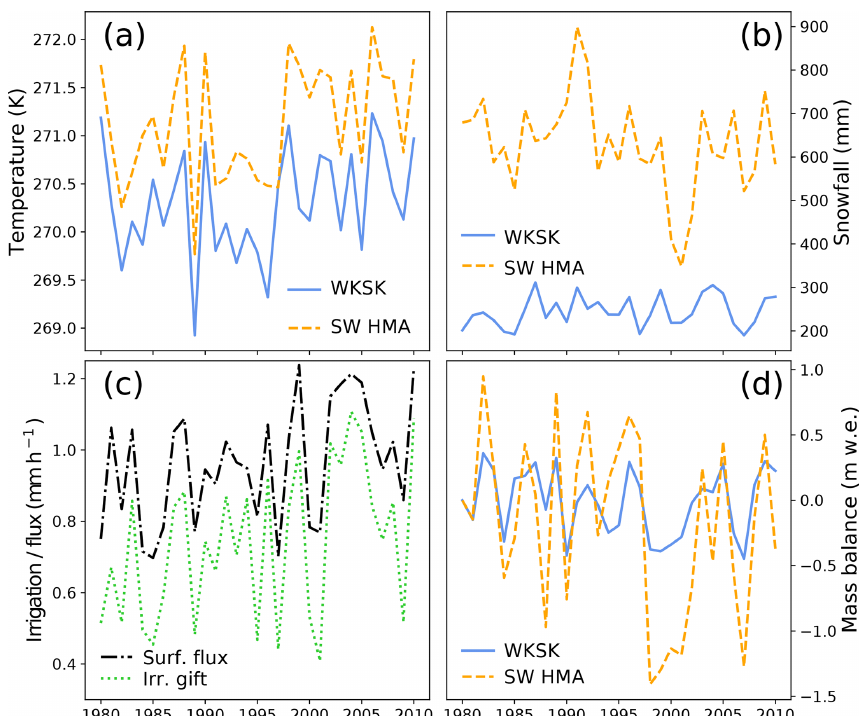
Figure 9. Time series of annual mean temperature (a) , annual snowfall (b) , and mass balance (d) for two nearby 2 ◦ × 3 ◦ bins in the WKSK and south-western HMA that have, on average, growing glaciers (38 to 40 ◦ N, 73 to 76 ◦ E; blue lines) and shrinking glaciers (35 to 37 ◦ N, 72 to 75 ◦ E; dashed orange lines). Panel (c) shows the time series of annual irrigation gift (dotted green line) and annual surface moisture flux (dot-dashed black line) for the most heavily irrigated point in the